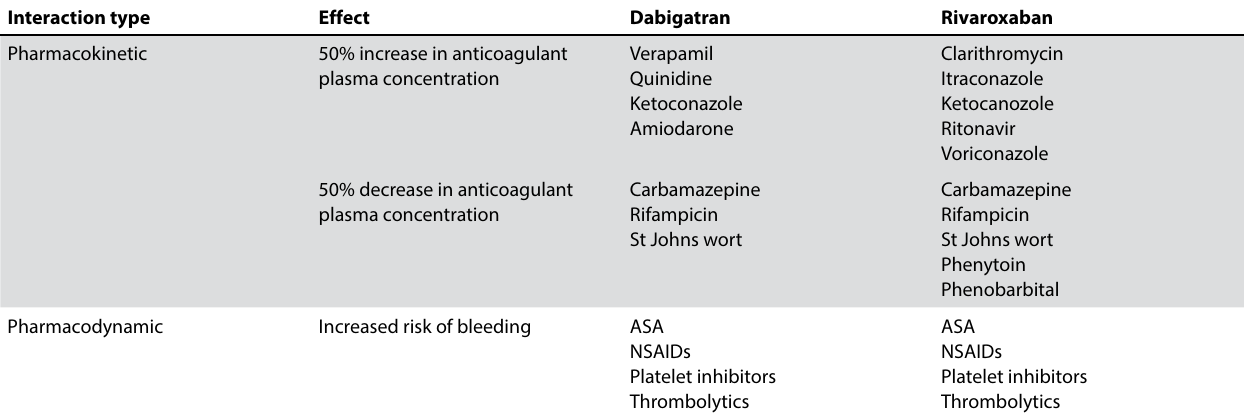
Table III. Drug-drug interactions Interaction